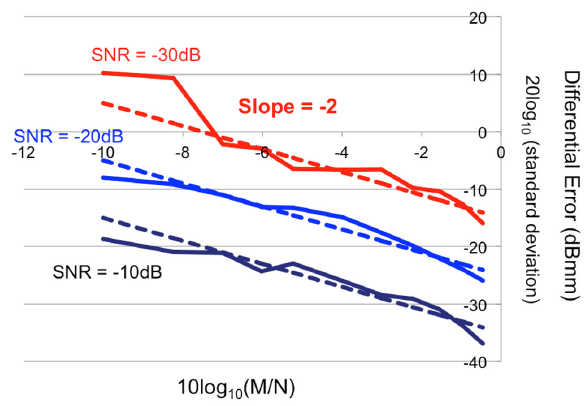
Figure 8. Differential displacement error in function of M/N for different SNR (simulated data).